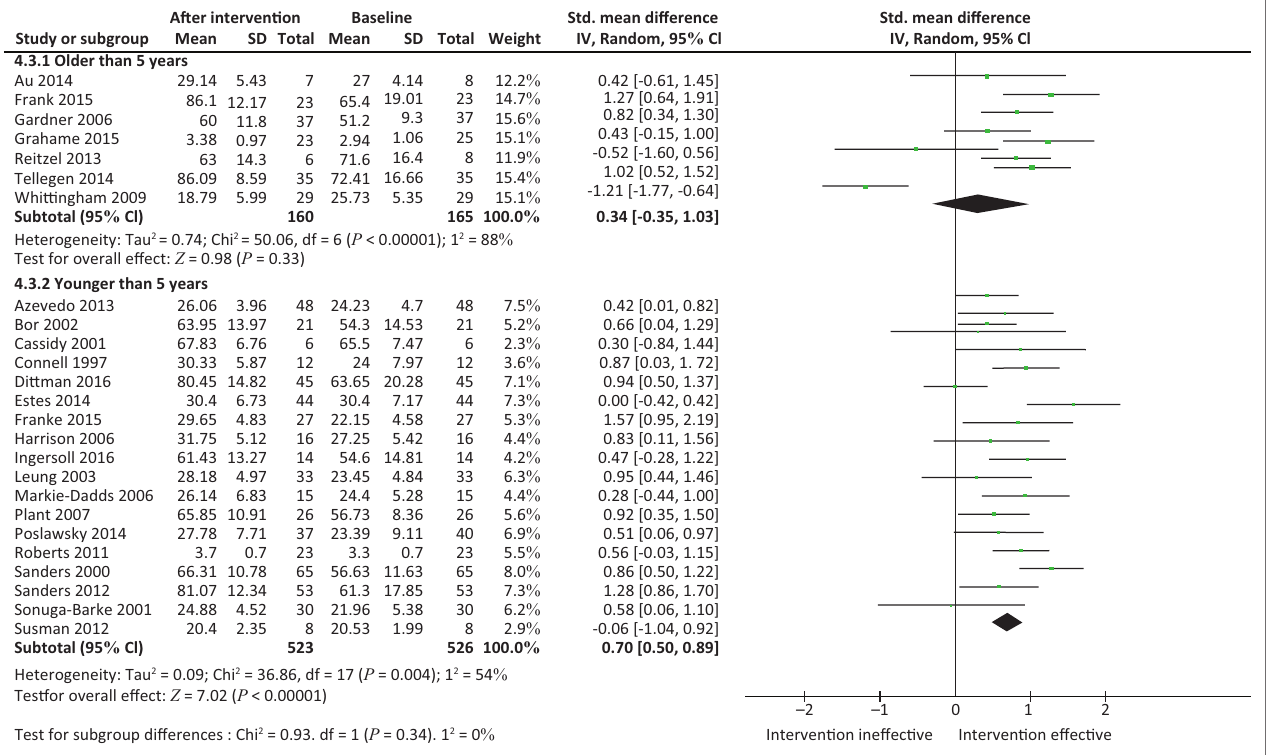
FIGURE 4: Random effects meta-analysis of the summative effects of parent training programmes according to child